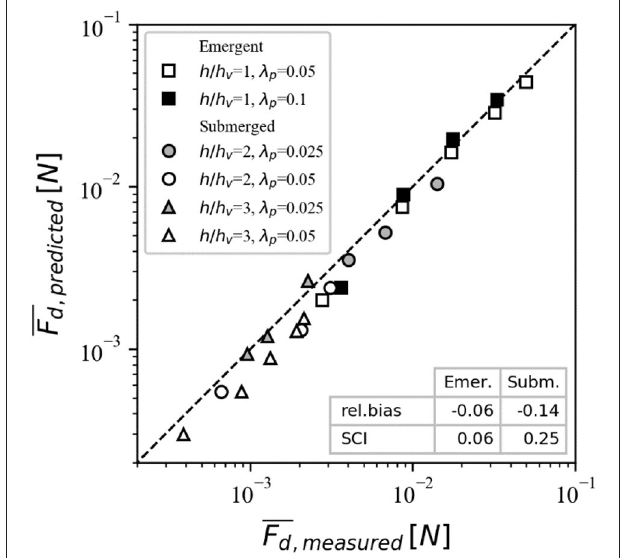
FIGURE 9 | Comparison between the measured depth-averaged in-canopy flow velocity ( U sub m ) and the estimated in-canopy constricted cross-section velocity ( U sub c ) in submerged